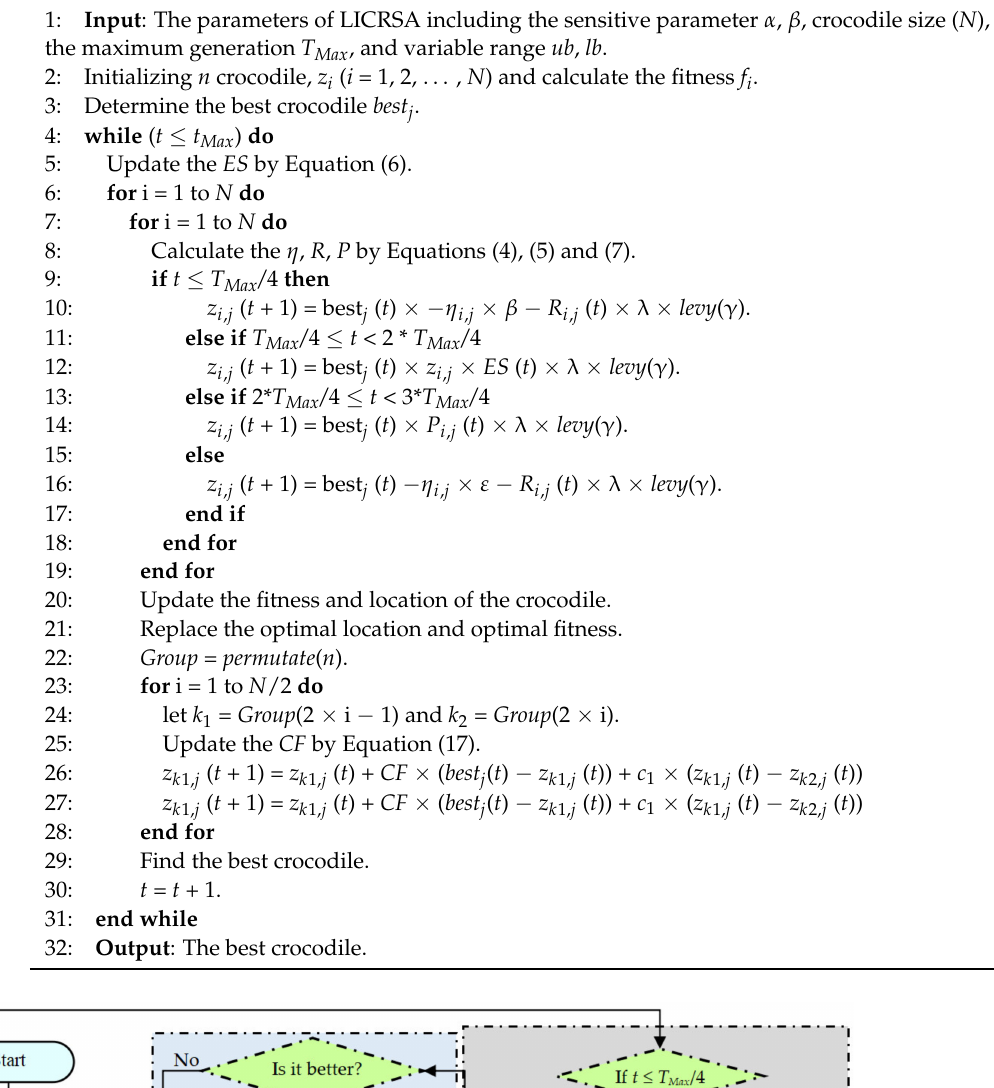
Algorithm 2: The framework of the LICRSA